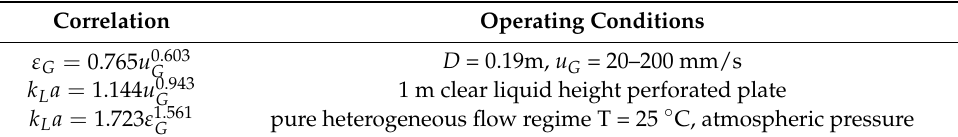
Table 3. Correlations for gas holdup and volumetric mass transfer coefficient obtained in coalescent liquid (distilled water).